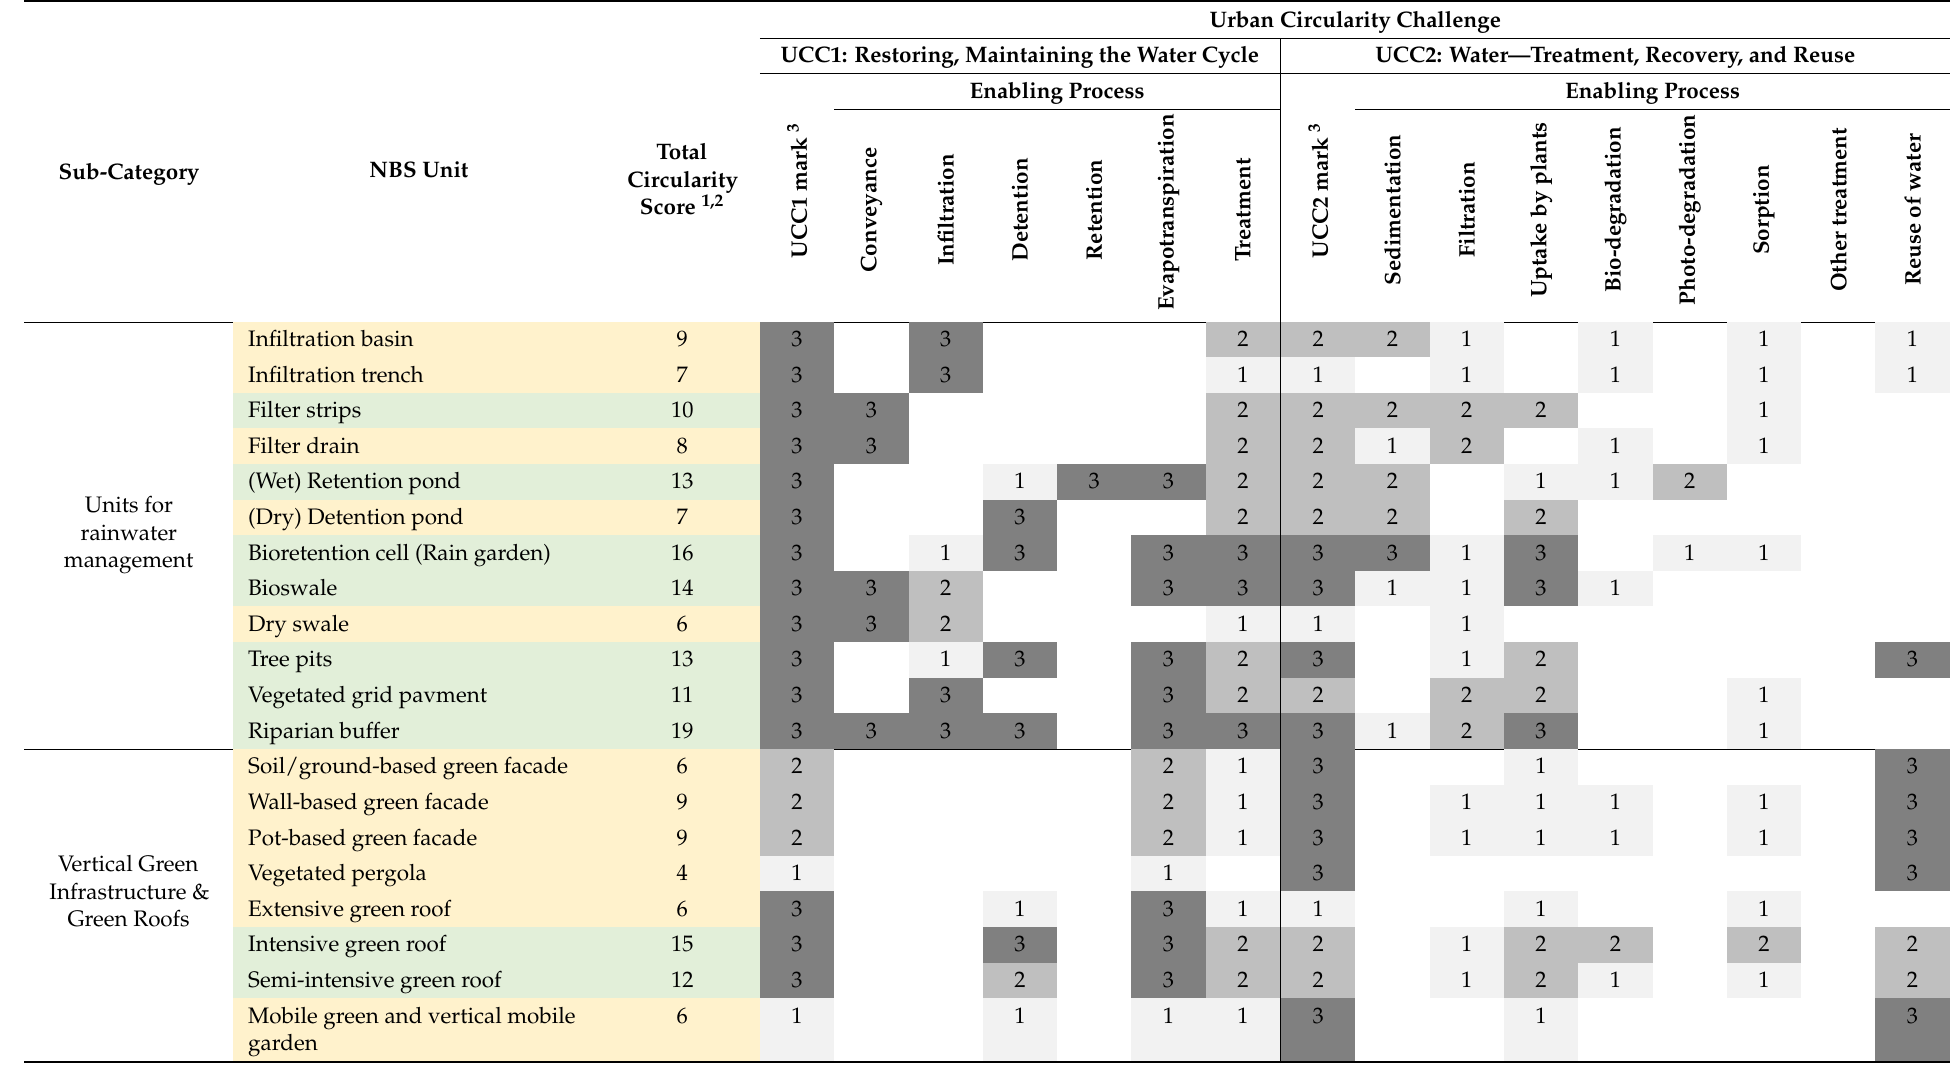
Table A2. Case -studies, models, theories, and lab-scale of representative NBS units (Table A1) and qualitative assessment of the NBS and supportive units *.